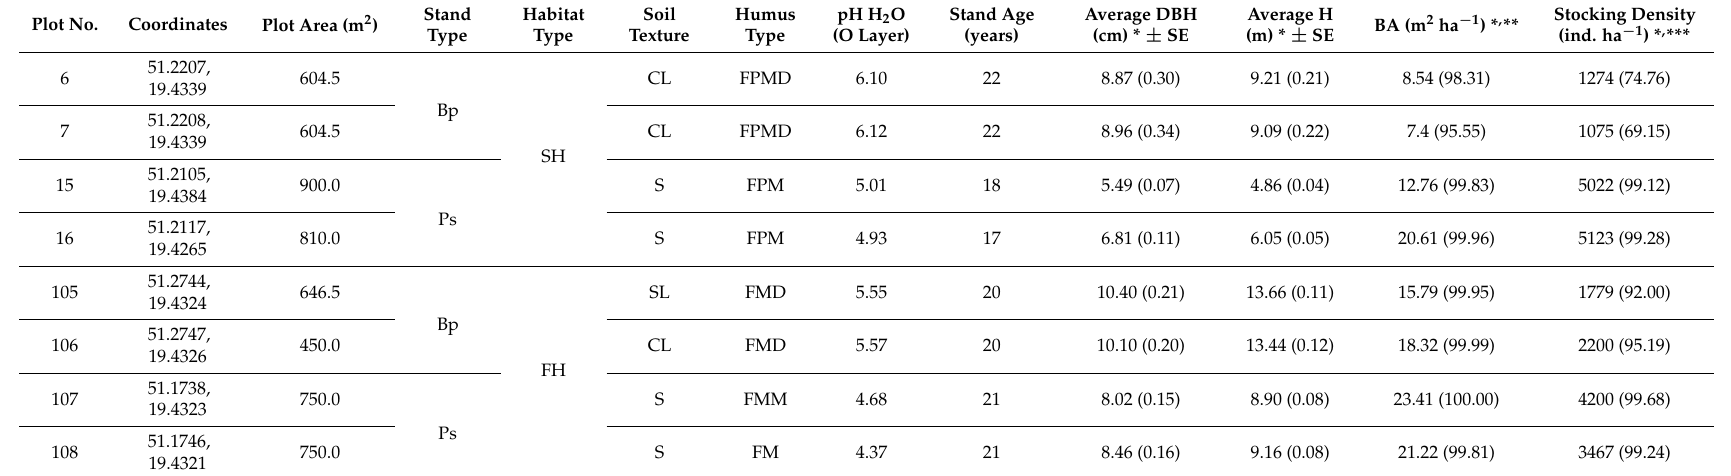
Table A1. Basic characteristics of sample plots (measurements were taken in 2011 and 2012). Abbreviations: Bp— Betula pendula Roth, Ps— Pinus sylvestris L., SH—spoil heap, FH—forest habitat, CL—clay loam, S—sand, SL—sandy loam, BA—basal area at breast height, DBH—diameter at breast height, H—tree height,